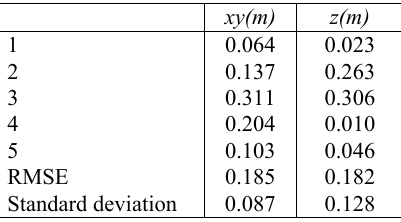
Table 3. Accuracy validation of UAV height